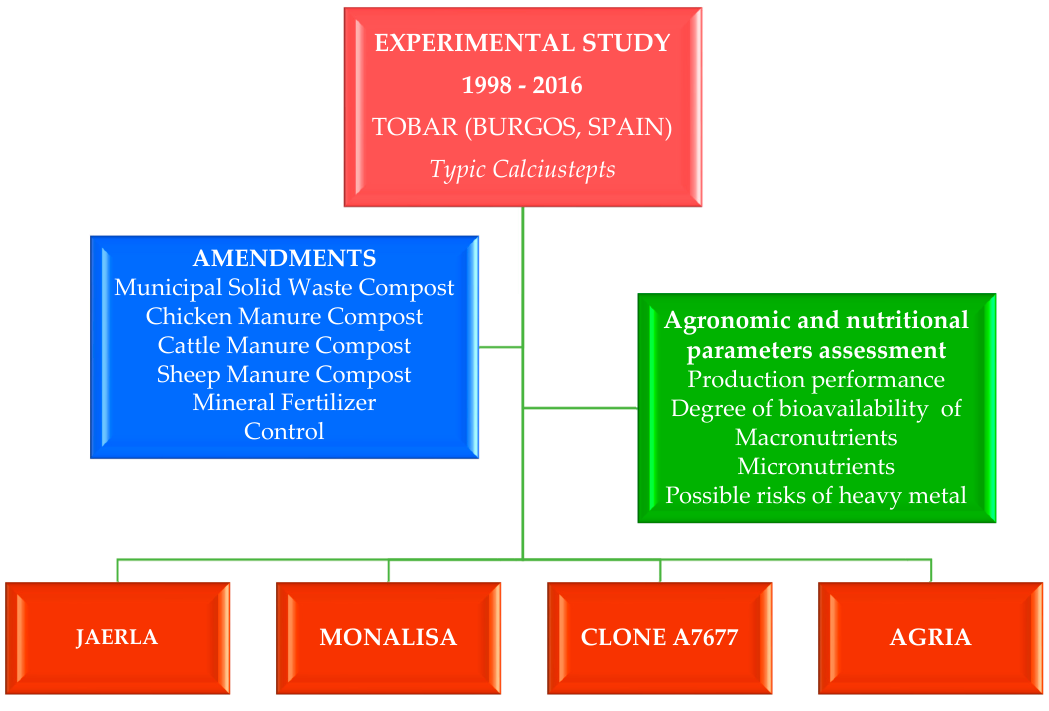
Figure 1. Flow diagram of the experimental field study. Table 1. Main analytical characteristics of the soil used in this study.